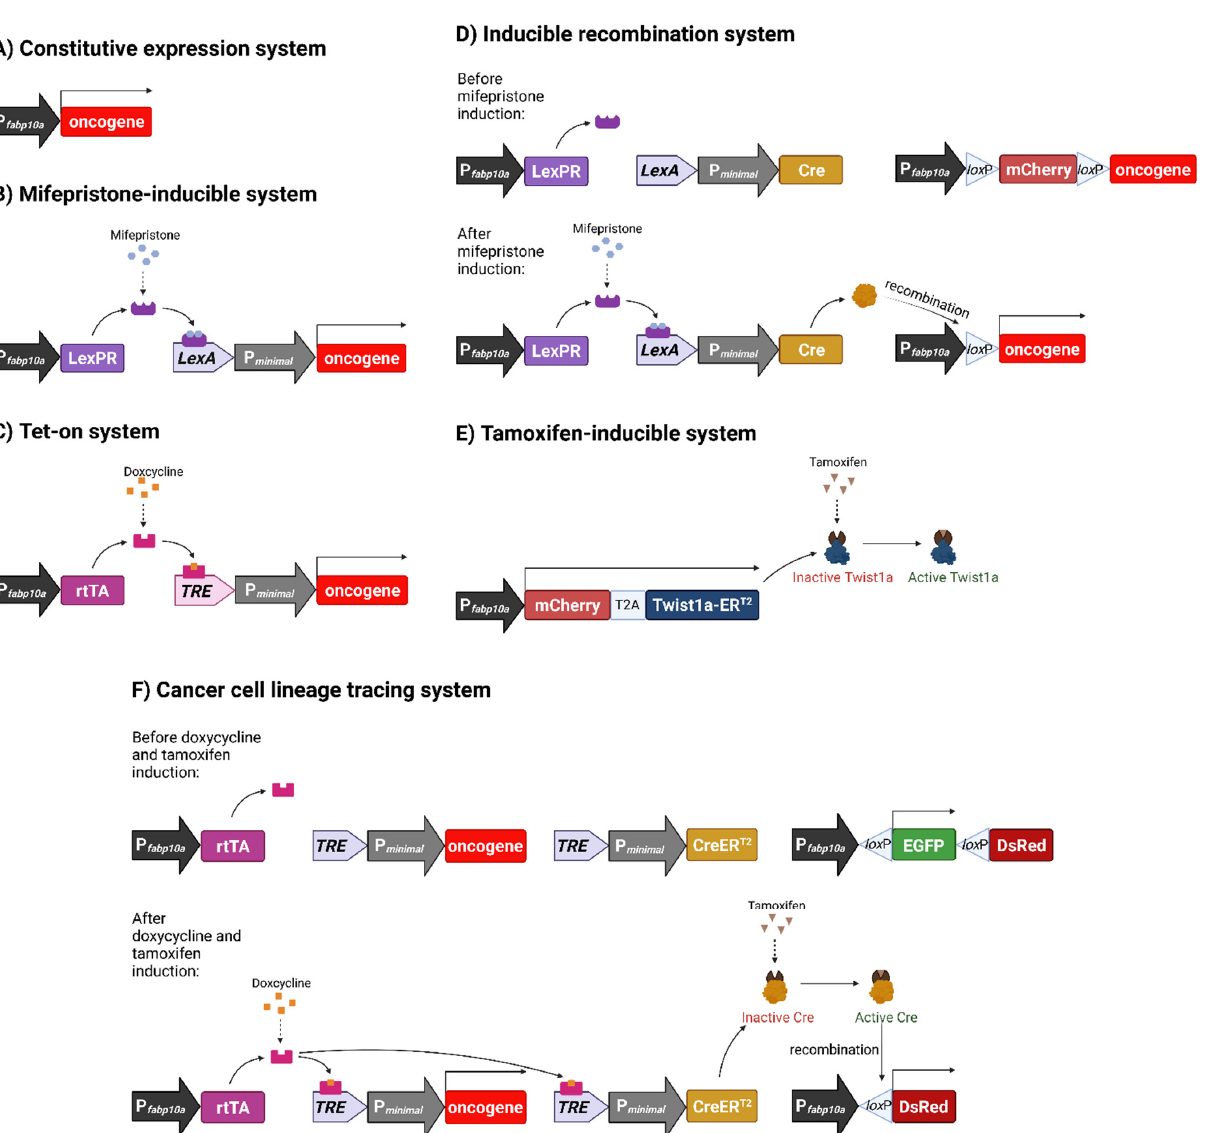
Figure 1. Schematic representation of various inducible systems we used for development of liver cancer models in transgenic zebrafish. ( A ) Constitutive expression system. Oncogene expression is under direct control of the hepatocyte-specific fabp10a promoter, causing oncogene to be constitutively expressed. ( B ) Mifepristone-inducible system. fabp10a promoter is used to transcribe a chimeric LexPR transactivator, which consists of the DNA binding domain of the bacterial LexA protein, the ligand binding domain of the human progesterone receptor (PR) and the activation domain of human p65 transcription factor. LexPR transactivator is activated by the mifepristone ligand and binds to the LexA operator to activate the transcription of the downstream oncogene. ( C ) Tet-on system. The reverse tetracycline-controlled transactivator (rtTA) is transcribed by the fabp10a promoter, but it becomes activated only in the presence of doxycycline and, in turn, it binds to the Tet Response Element (TRE) to activate the transcription of downstream oncogene. ( D ) Inducible recombination system. It incorporates the Cre-loxP components into the mifepristone-inducible system in order to induce permanent oncogene expression via genomic recombination. In this system, mifepristone activates LexPR, which binds the LexA operator to allow the expression of Cre recombinase. Cre recognises loxP sequences and excises the mCherry STOP cassette to permanently activate the downstream oncogene. ( E ) Tamoxifen-inducible system. A Twist1a-ER T2 fusion gene ( twist1a and ligand binding domain of estrogen receptor [ER]) is constitutively transcribed by fabp10a promoter but the activation of the fusion protein requires the ligand, tamoxifen. T2A is a self-cleavage peptide to allow simultaneous production of two separate proteins. ( F ) Cancer cell lineage tracing system. Doxycycline activates rtTA, which in turn causes transcription of both xmrk oncogene and CreER T2 . CreER T2 is activated by tamoxifen and excises the floxed EGFP sequence to cause the change of the expression of fluorescent protein genes. Figure created with BioRender.com (accessed on 23 September